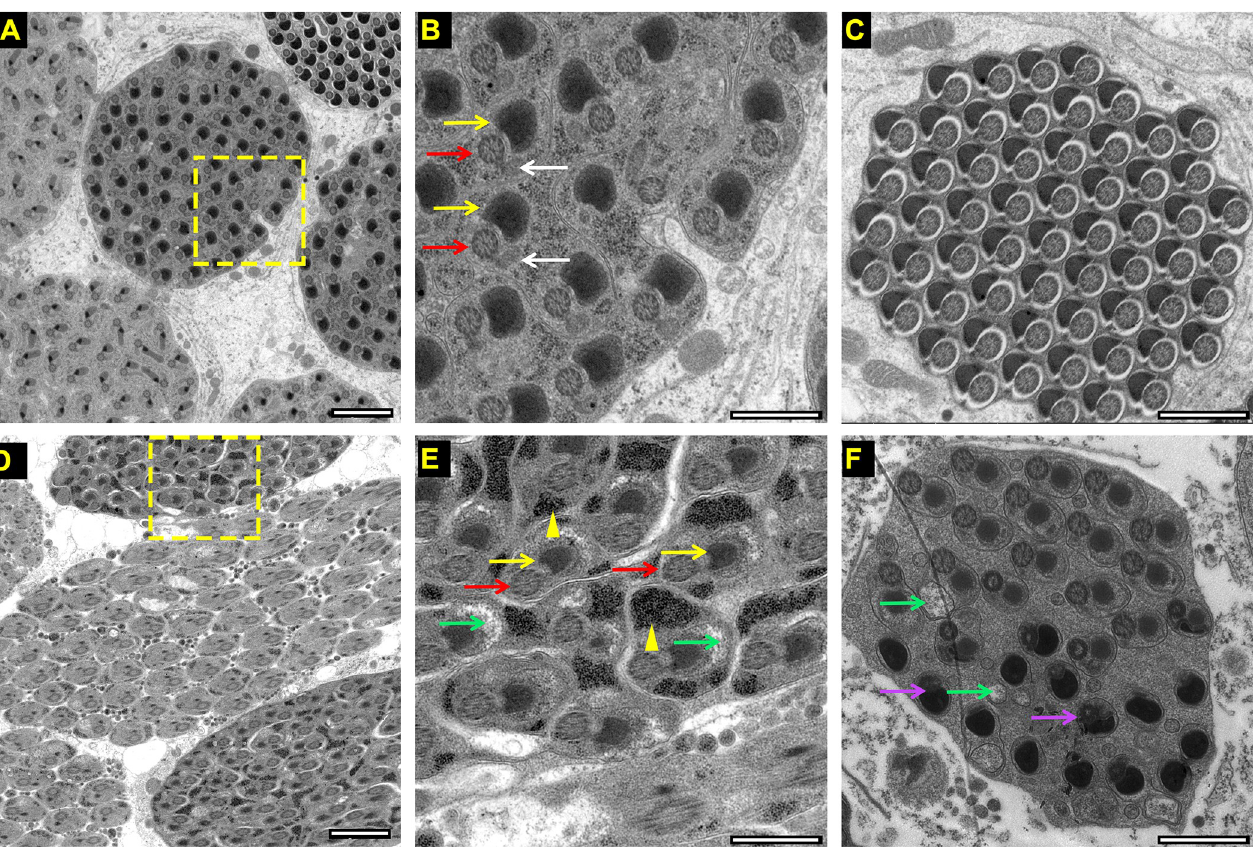
Fig 9. Transmission electron microscope (TEM) of transverse section of testes of 1d Wolbachia -uninfected (A, B, C) and infected (D, E, F) D . melanogaster . Yellow arrows indicate major mitochondrial derivatives. White arrows indicate minor mitochondrial derivatives. Red arrows represent axoneme. Yellow arrowheads show irregular black mass. Green arrows show vacuoles, and purple arrows indicate the fusing of the black mass with axoneme. Bars: 2 μ m (A, D); 1 μ m (B, C, E,